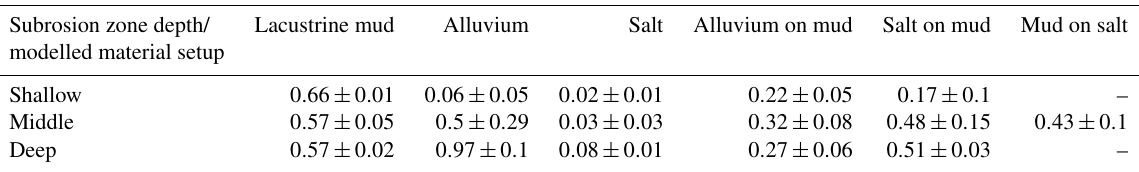
Figure 9. Evolution of maximum shear stress during cavity growth and sinkhole collapse in end-member Dead Sea materials. Shown here are selected stages in the development of cavity/sinkhole in salty mud (a) , alluvium (b) and rock salt (c) . The same model setups as in Fig. 8 are used. Table 5. Critical thickness to diameter ratios for modelled sinkhole collapse onsets. The error is based on the mean between different particle assemblies for each